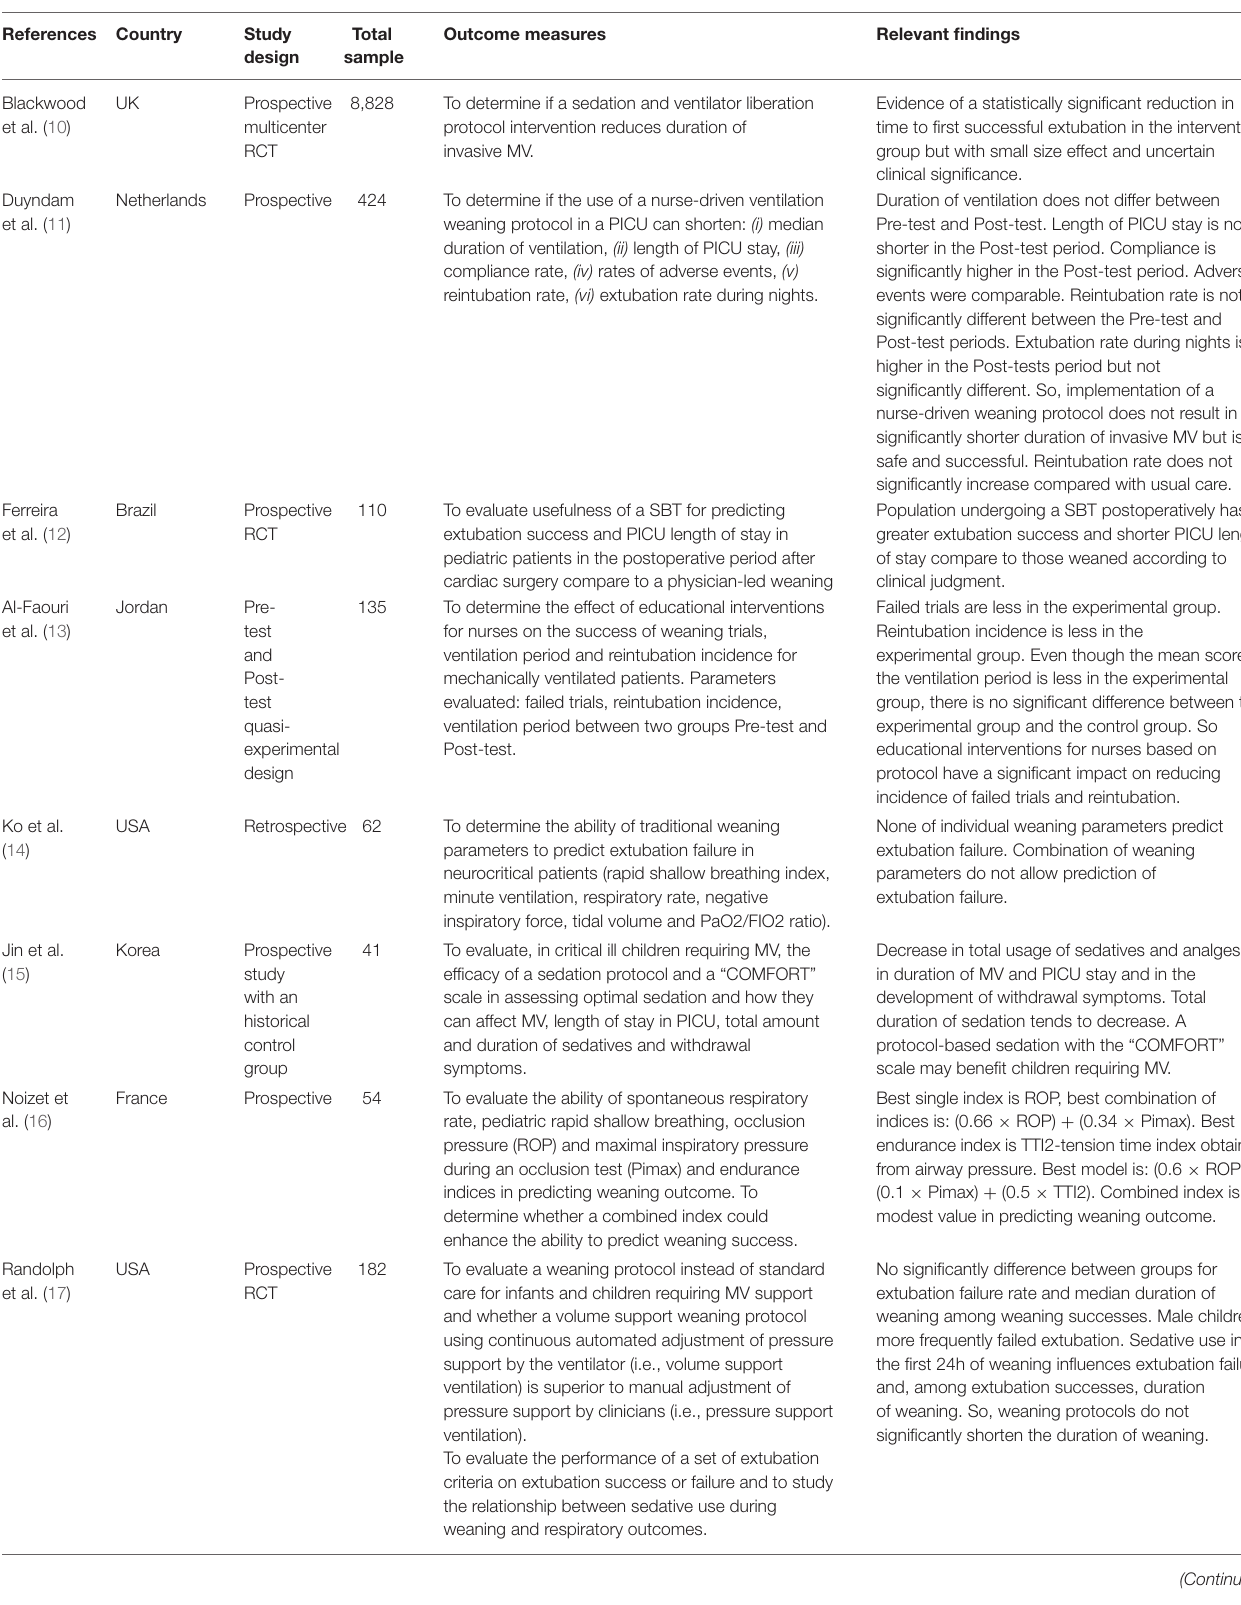
TABLE 1 | Weaning from mechanical ventilation: summary of the reviewed publications. References